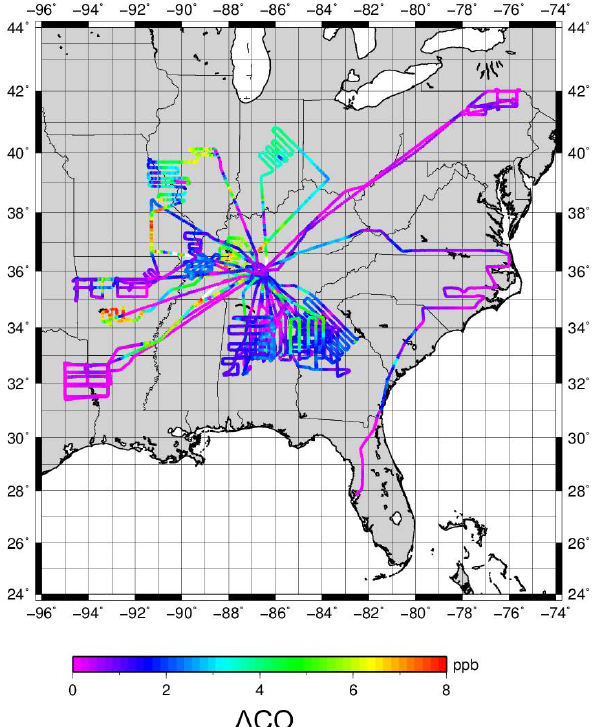
Figure 3. CMAQ-simulated (cid:49) CO (ppb), i.e., the CO concentration difference between CMAQ simulation with and without fire emis- sions, extracted along the overall SENEX flight paths during the SENEX campaign between 10 June and 20 July